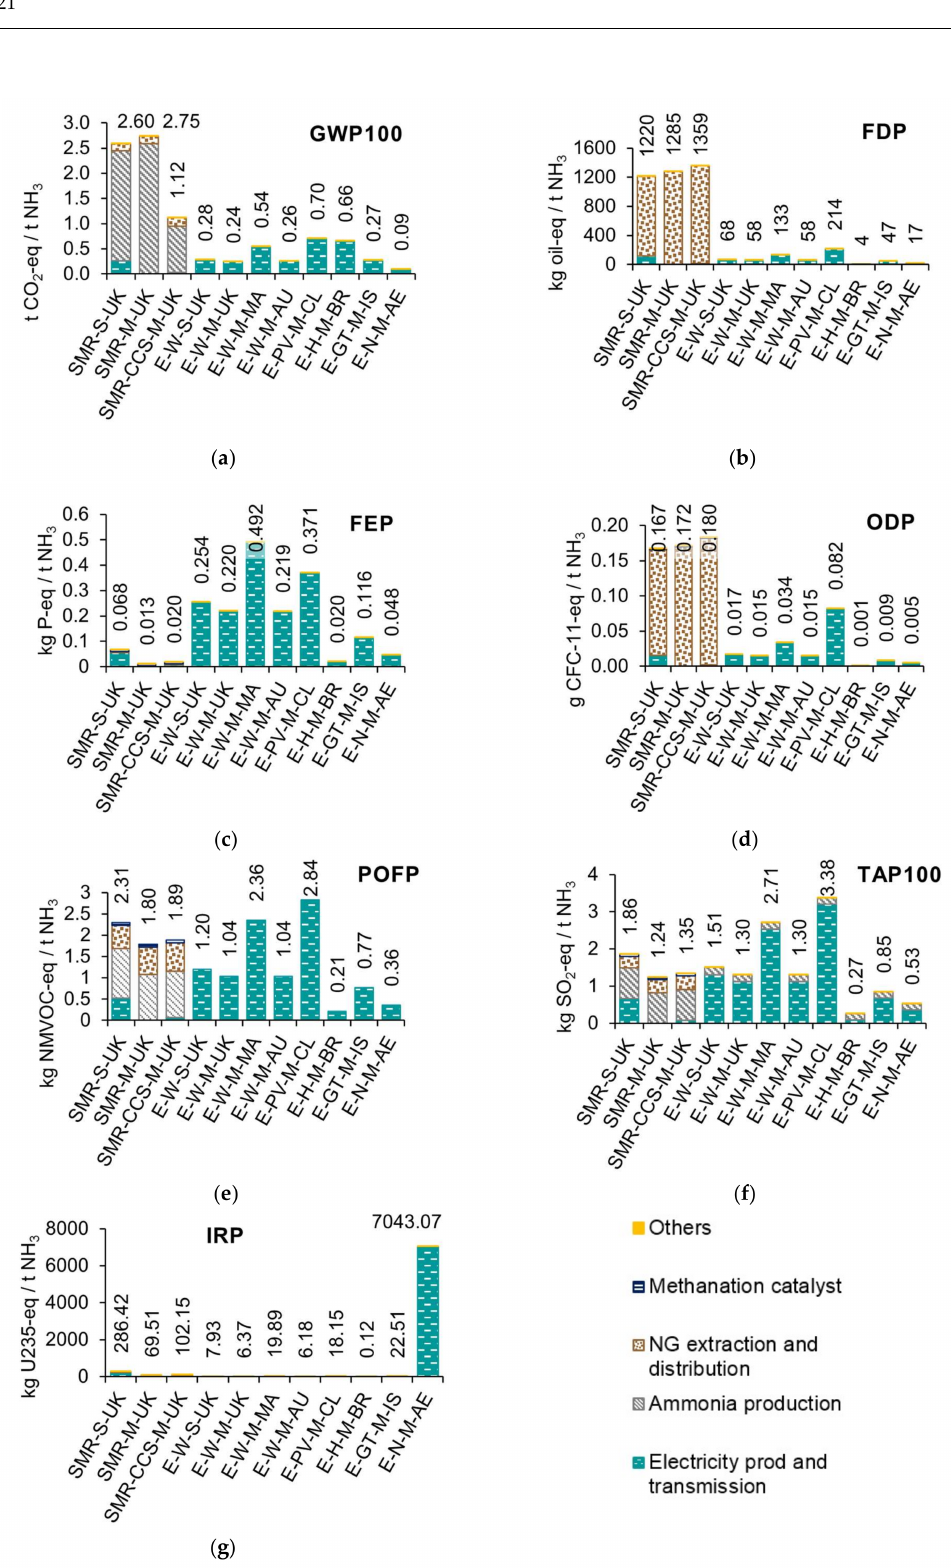
Figure 4. Contribution analysis for the impact category indicator results of 1 kg ammonia at the production plant gate for ( a ) global warming potential (GWP100), ( b ) fossil depletion potential (FDP), ( c ) freshwater eutrophication potential (FEP), ( d ) ozone depletion potential (ODP), ( e ) photochemical oxidation formation potential (POFP), ( f ) terrestrial acidification potential TAP100, ( g ) ionizing radiation potential (IRP). SMR: steam methane reforming, E: electrolysis, CCS: carbon capture and storage, S: small-scale 20,000 ton per annum ammonia plant, M: mid-scale 100,000 ton per annum ammonia plant, PV: photovoltaic, W: wind, H: hydro, GT: geothermal, N: nuclear, UK: United Kingdom, MA: Morocco, AU: Australia, CL: Chile, BR: Brazil, IS: Iceland, AE: United Arab